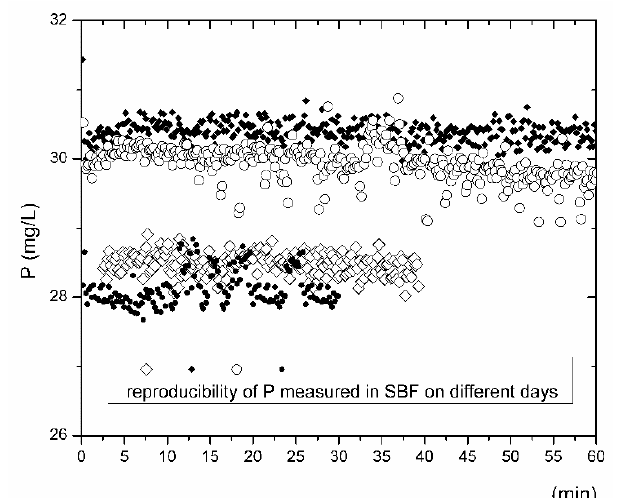
Figure 1. Reproducibility of the determination of Ca content during the inline ICP tests as measured on different days (represented by different symbols) in the fluid freshly prepared according to the Kokubo recipe [2].